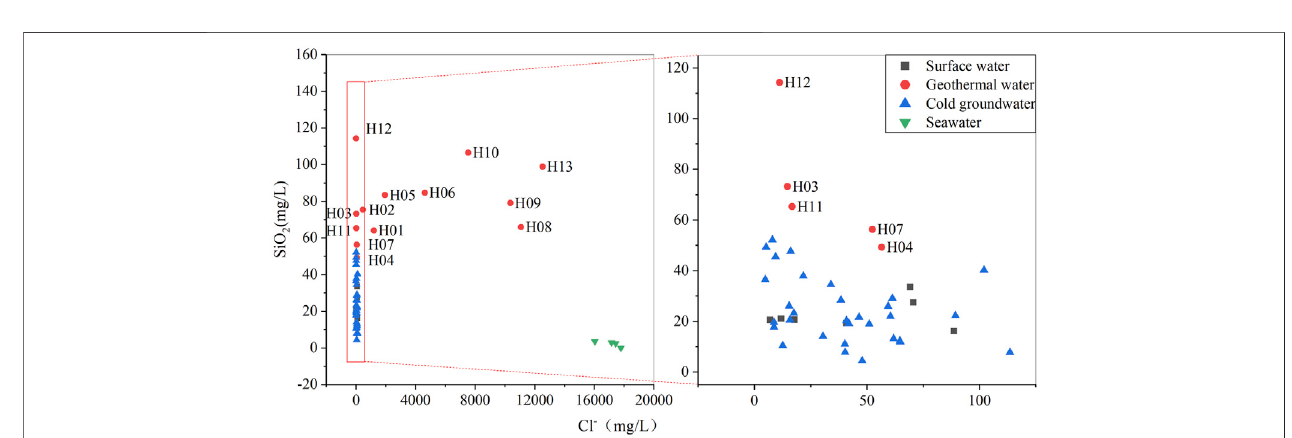
FIGURE 3 | Distribution of SiO 2 and Cl − concentrations in groundwater in Xiamen.